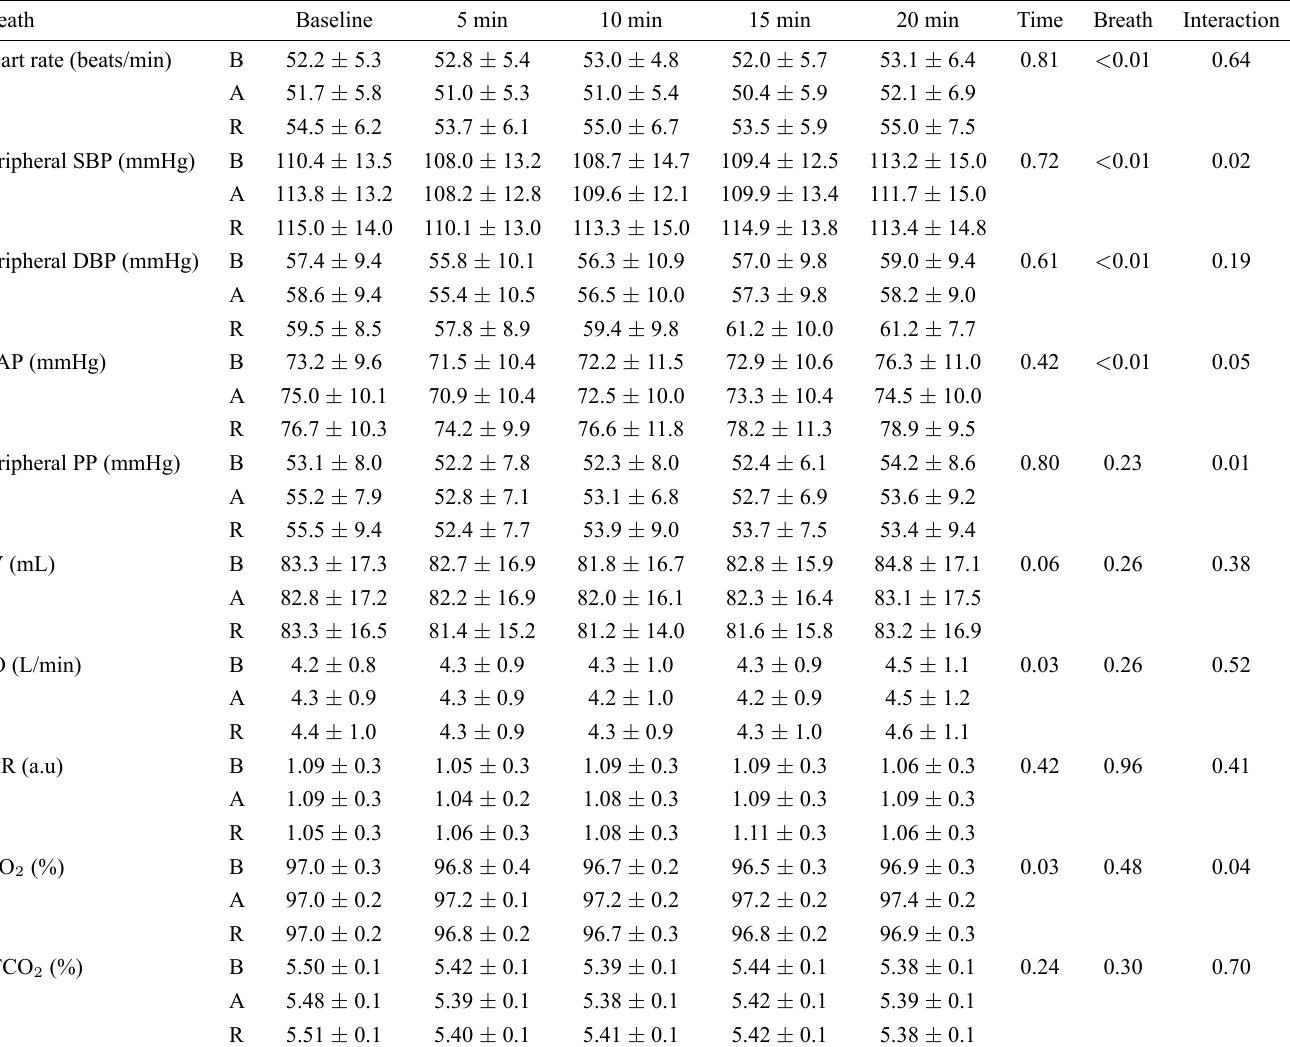
Table 1. Hemodynamic and respiratory variables during the